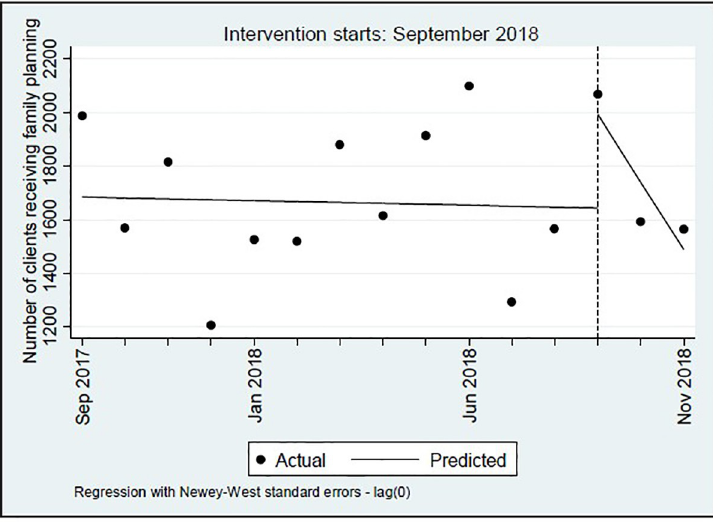
Fig 2. Graph of total number of FP clients per month in the ten pilot intervention facilities from September 2017 through November 2018, Tanzania 2018.